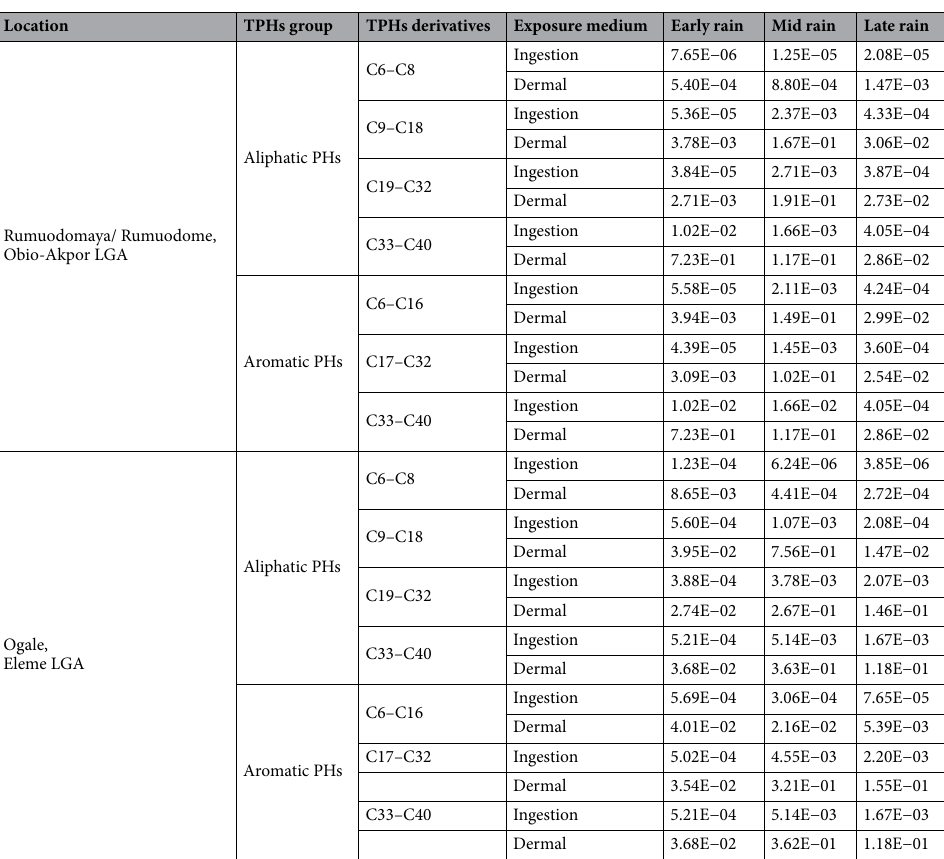
Table 10. Average daily intake of TPHs exposure in rainwater for